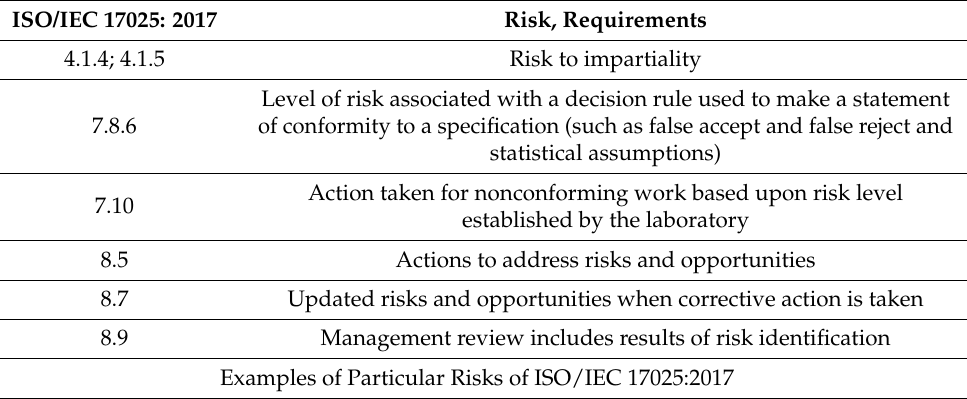
Table 1. Identification of risk of ISO/IEC 17025:2018,